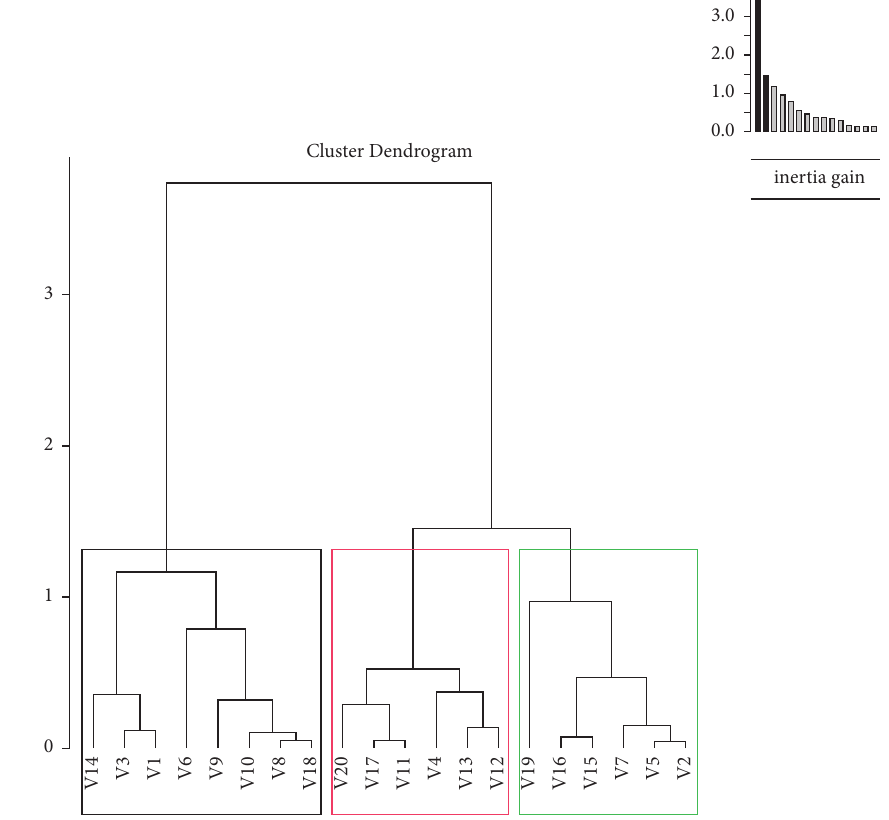
Figure 5: Hierarchical tree of individual varieties under drought stress at vegetative stage.